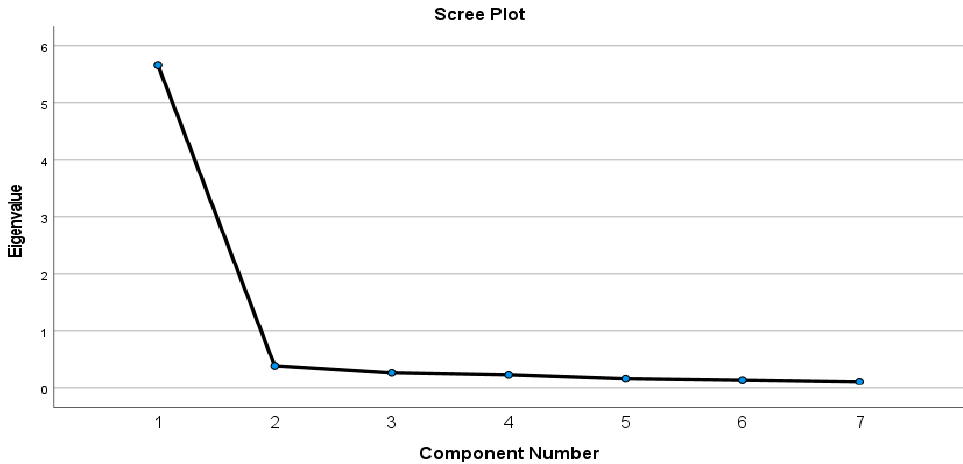
Figure 1. The scree plot of the sport-specific doping self-regulatory efficacy